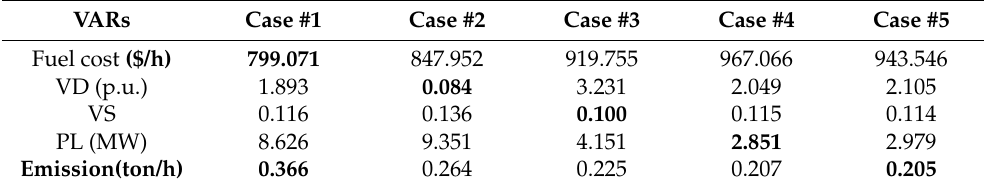
Table 2. Objectives functions for single objective functions for the IEEE 30-bus test system using TFWO (CASES